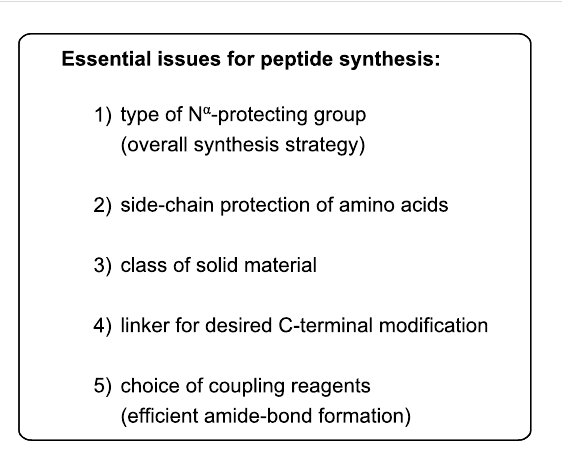
Figure 1: Five issues that have to be resolved prior to peptide syn-